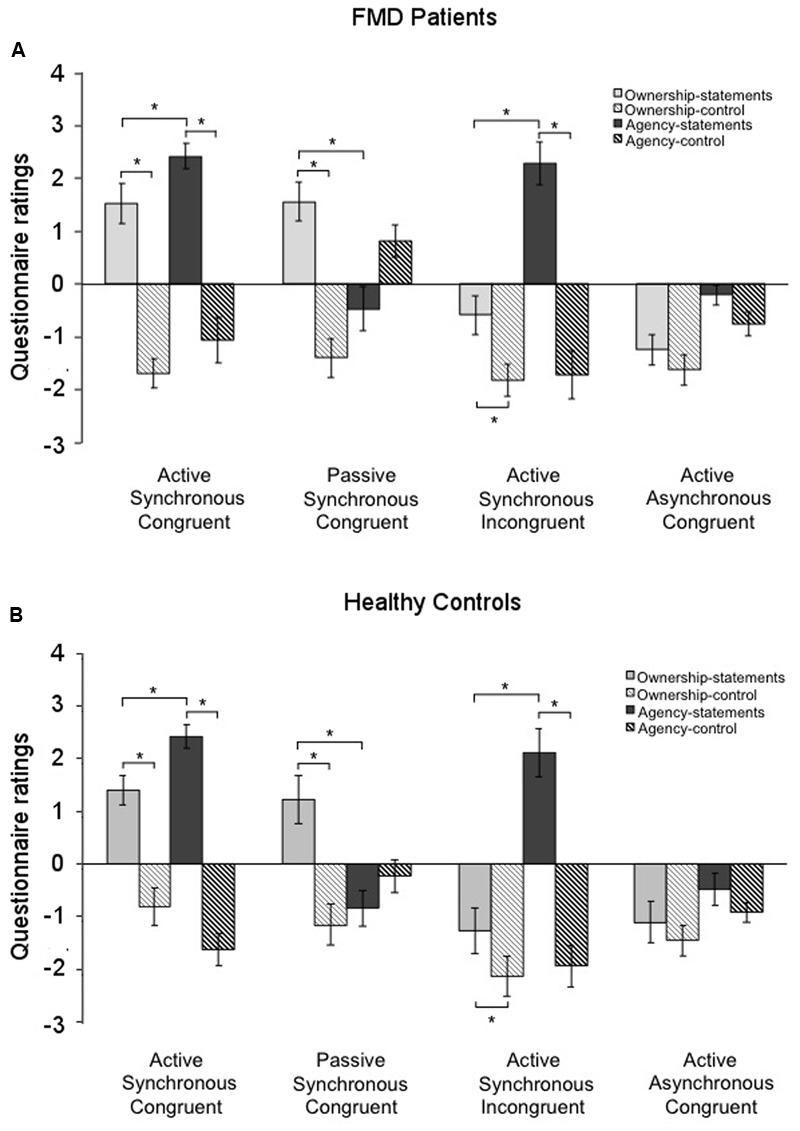
Questionnaire ratings in the two groups. Mean scores for the ownership-statements (light gray columns), ownership-controls (light gray striped columns), agency-statements (dark gray columns), and agency-controls (dark gray striped columns) in the functional movement disorders group (A) and the healthy controls group (B). Gray lines and asterisks show significant comparisons within conditions. Note that in both groups the Passive Synchronous Congruent condition elicited ownership but not agency, and that conversely the Active Synchronous Incongruent condition elicited agency but not ownership, suggesting a double dissociation between agency and ownership. Error bars indicate standard errors.